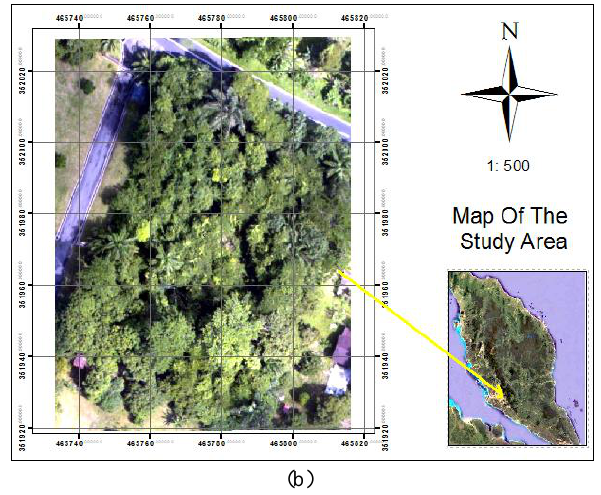
Figure 2. Map of study area covered with (a) rubber trees vegetation; (b) mixed forest.